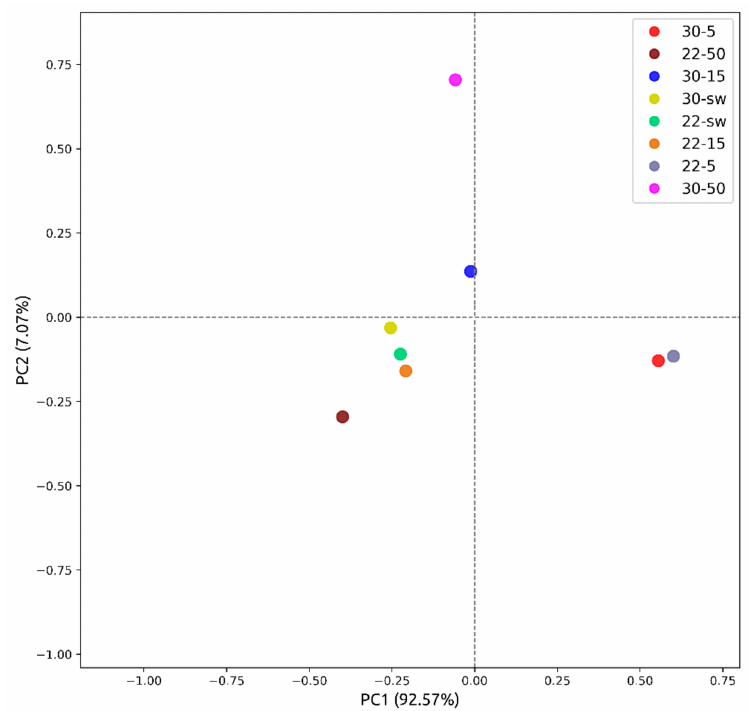
Figure 7. The principal component analysis (PCA) of various fungal